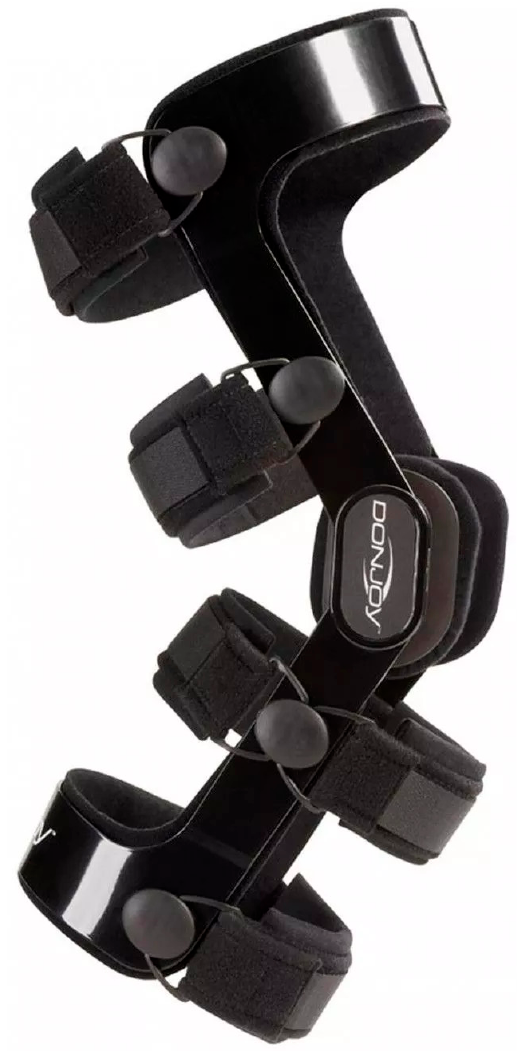
Figure A1. Medi M.4 brace, medi GmbH, Bayreuth, Germany (https://www.medi.de/produkte/m-